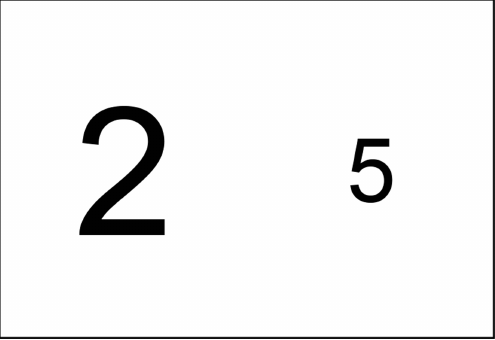
Figure 2. Example of an incongruent trial in the size congruity task